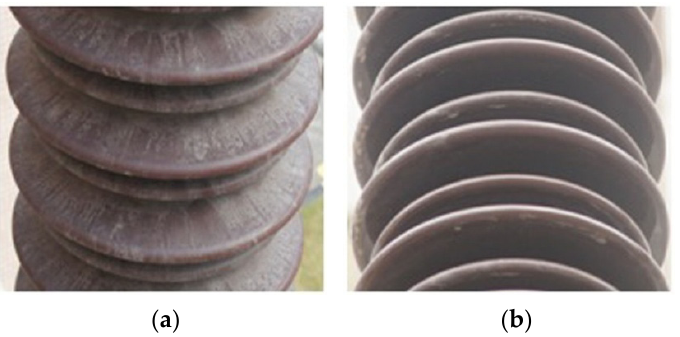
Figure 2. Comparison of upper and lower plates of a pillar insulator: ( a ) the upper plate of a pillar insulator; ( b ) the lower plate of a pillar insulator.